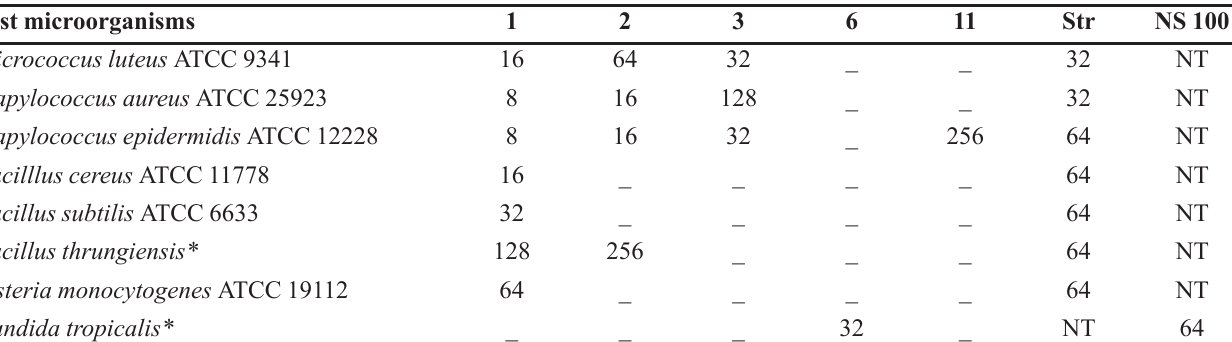
TABLE I - Antimicrobial activities of unsymmetrically substituted imidazolium salts (1000 µg mL -1 ) (Inhibition zone mm) Test Microorganisms Escherichia coli ATCC 35218 Salmonella typhimurium ATCC 14028 Micrococcus luteus, ATCC 9341 Stapylococcus aureus ATCC 25923 Stapylococcus epidermidis ATCC 12228 Bacilllus cereus ATCC 11778 Bacillus subtilis ATCC 6633 Bacillus thrungiensis* Entereococcus faecalis ATCC